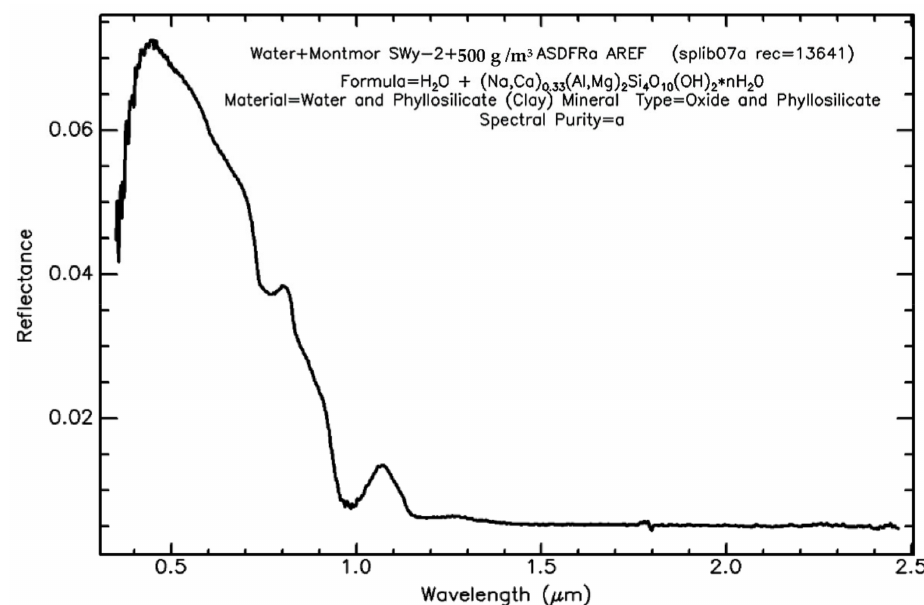
Figure 8. Spectral curve for the montmorillonite suspensions in water, USGS Spectral Library Version 7, https://crustal.usgs.gov/speclab/QueryAll07a.php?quick_filter=water (accessed on 1 January 2022). Reprinted with permission from [39].